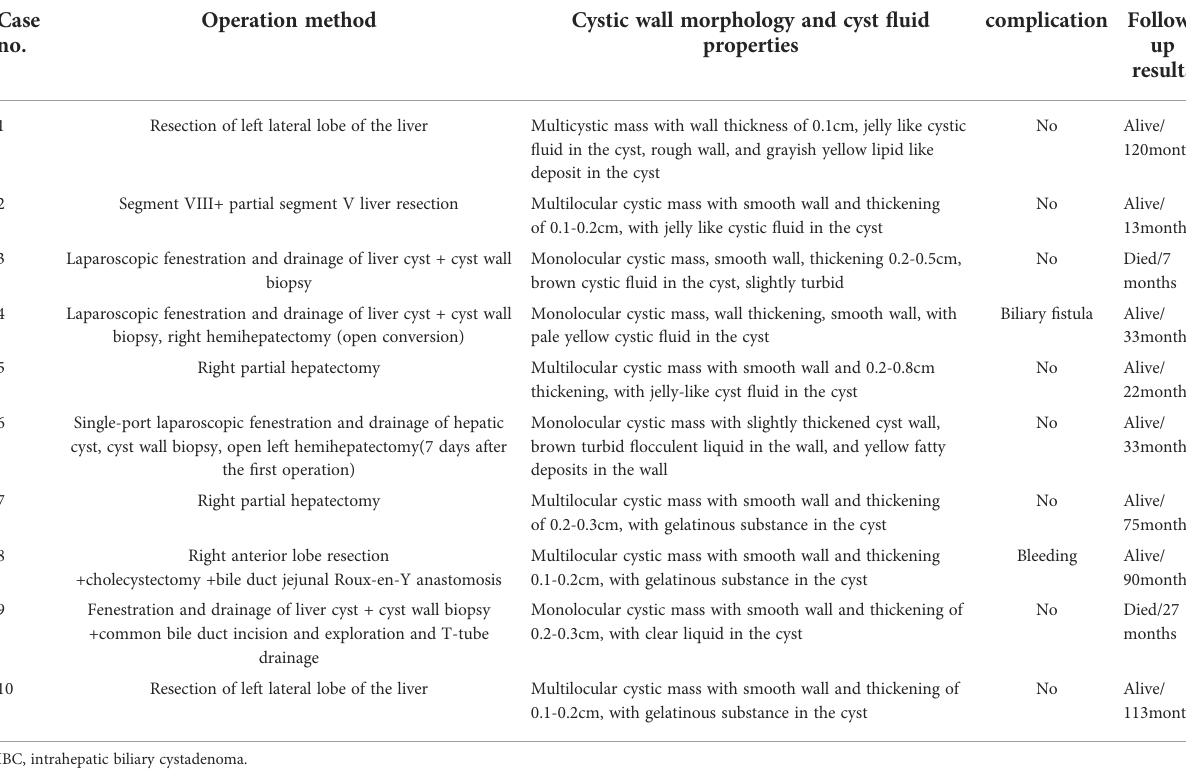
TABLE 2 Operation method, intraoperative condition and follow-up results of ten cases of IBC. Case